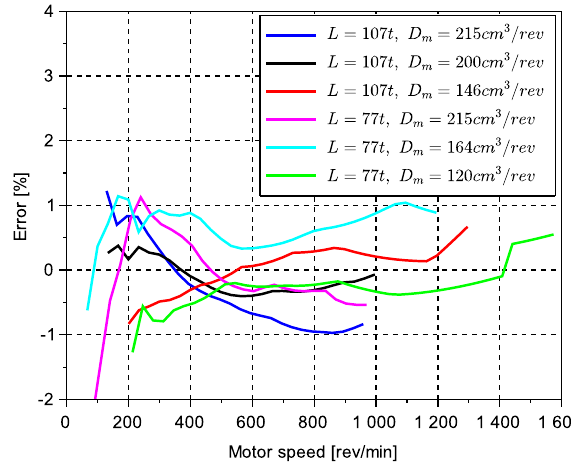
Figure 17: Model error in percentage of the nominal system torque.